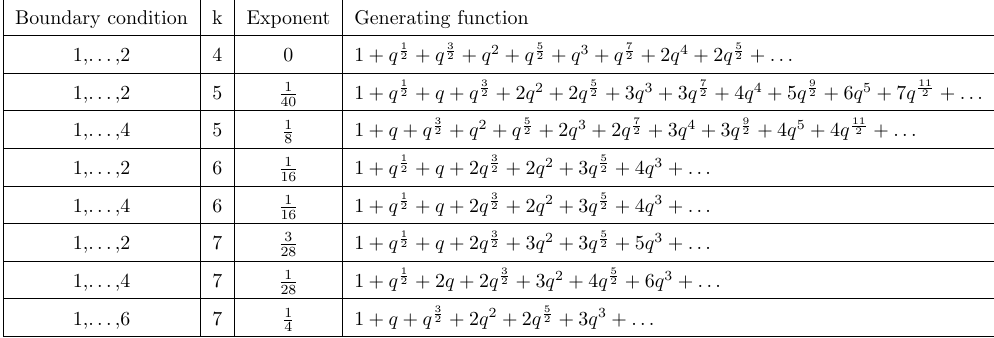
Table 5 . Generating functions in the RSOS model with an odd numbers of sites. The generating functions are written up to the number of terms that we have observed on the